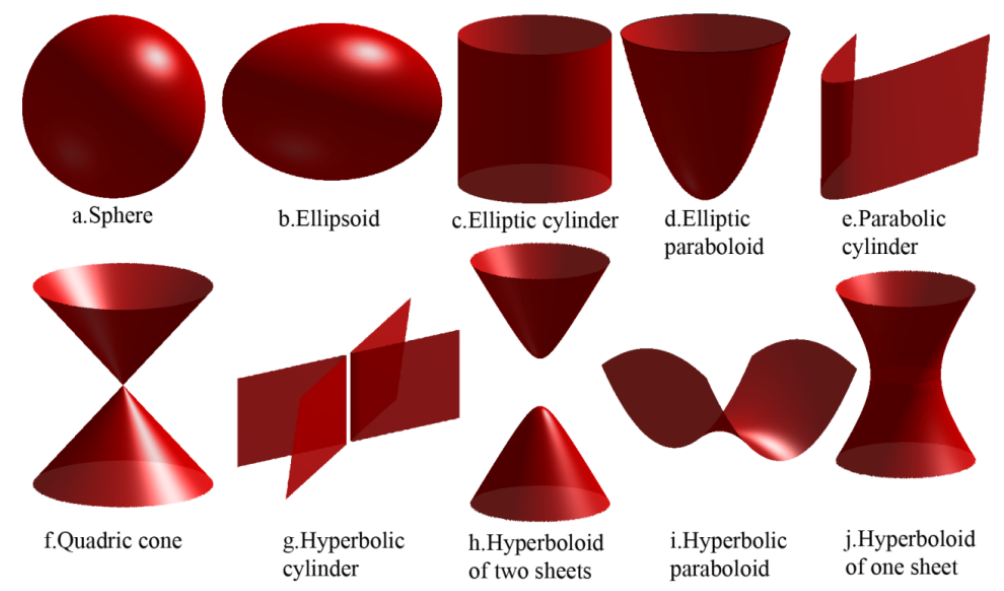
Figure 4. Possible quadric surfaces built from the intersection of a hypercone with a hyperplane